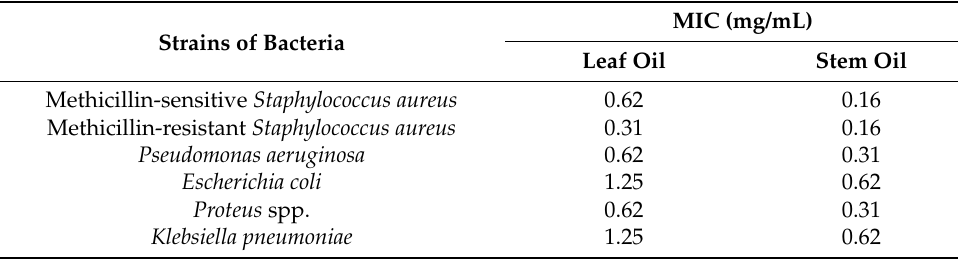
Table 3. MIC values of leaf and stem oils of F. japonicum